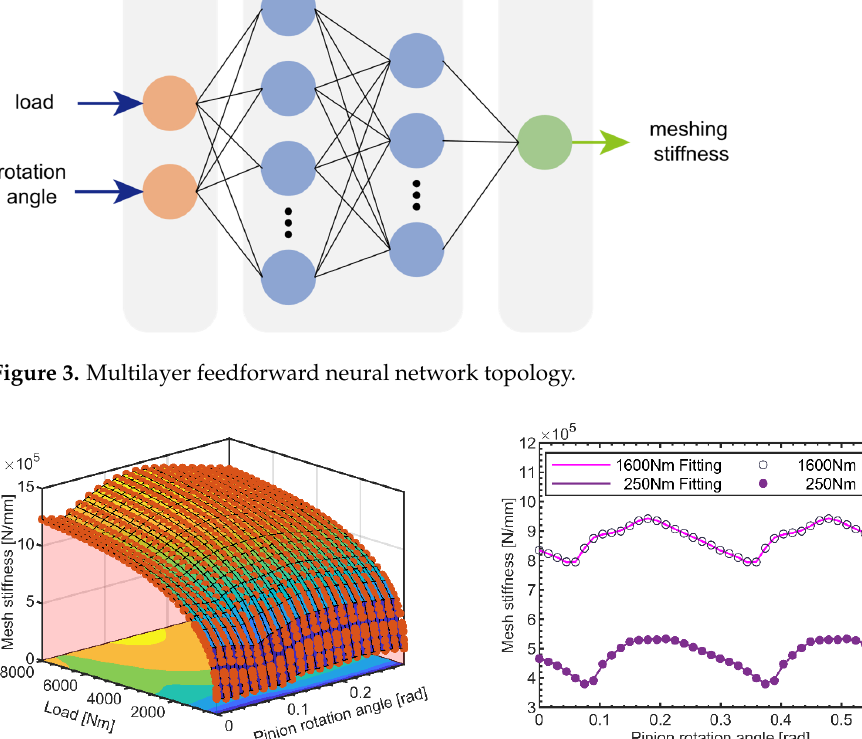
( b ) Figure 5. Mesh sti ff ness model of upper face gear: ( a ) neural network model; ( b ) veri fi cation of gen- eralization capability. Figure 6 illustrates the meshing sti ff ness at a fi xed load and the meshing sti ff ness as a function of the load. With the support sti ff ness shown in Table 2, the static meshing forces of Input Gear 1 with the lower and upper face gears were 8967 and 12,588 N, re- spectively. Furthermore, based on this meshing force, the meshing sti ff ness of Input Gear 1 with the lower face gear Kh16g and the upper face gear Kh17g was calculated for a given load. Kh16 and Kh17 are the meshing sti ff nesses calculated based on the meshing sti ff ness proxy model. Figure 6 shows that Kh16 is di ff erent from Kh16g and that Kh17 and Kh17g di ff er in value. The dynamic meshing forces of gear pairs of Input Gear 1 were calculated, as shown in Figure 7a,b, with load- fi xed and load-related meshing sti ff ness. In Figure 7a, Fn16g has more frequency components and a smaller average meshing force than Fn16. The minimum values of meshing forces Fn17 and Fn17g were 12,228 and 12,124 N, respec- tively, and the average values were 14,744 and 14,645 N, respectively. The load-sharing coe ffi cients obtained by Formula (38) were 1.368 and 1.376 under load-related and load- fi xed meshing sti ff ness, respectively. Therefore, associating the meshing sti ff ness with the load is bene fi cial to increasing the accuracy of the model of CFGSTTS dynamics. Table 2. Values of gear support sti ff ness. k x (N/mm)